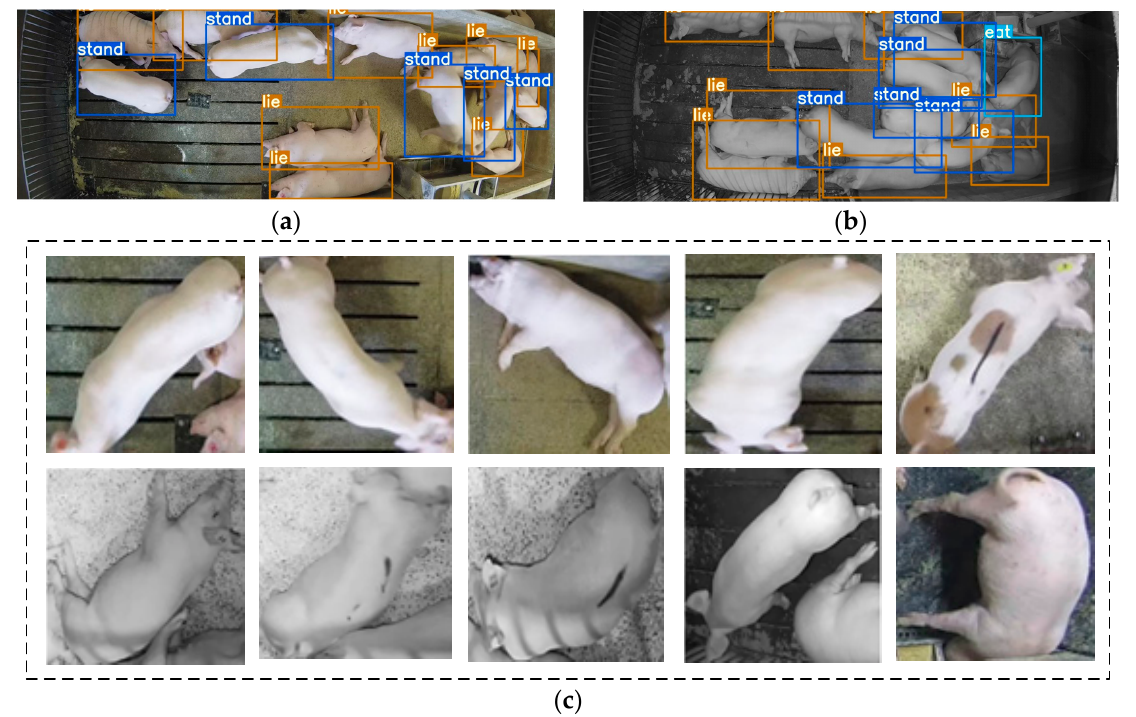
Figure 2. Part dataset of detection and tracking. ( a ) behavior-annotated images of video sequence 09# for detection, ( b ) behavior-annotated images of video sequence 10# for detection, and ( c ) part ReID dataset including 10 different pigs in day and night scenes for DeepSORT pig tracking.